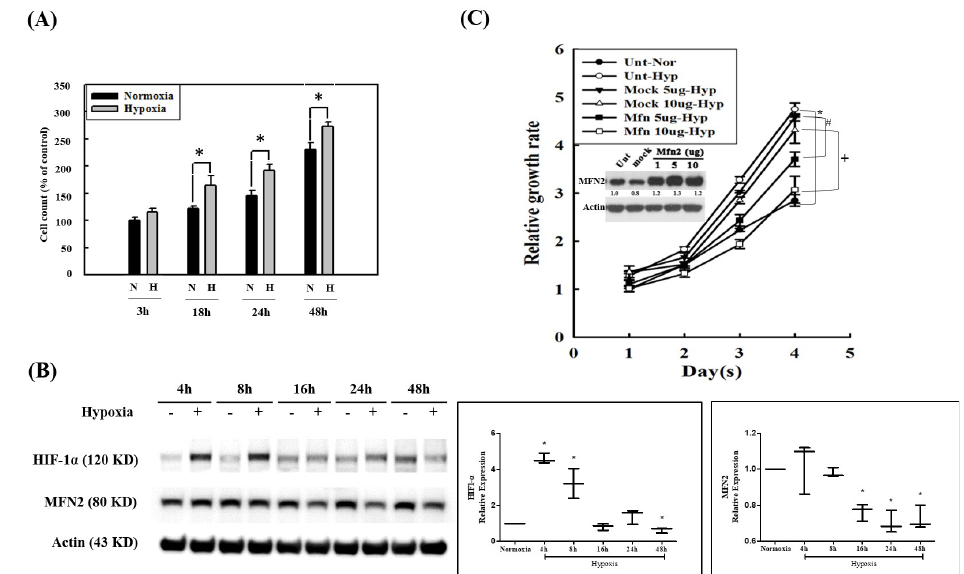
Figure 1. The role of MFN2 in hypoxia-induced proliferation. ( A ) HPASMCs were exposed to hypoxic (1% oxygen) or normoxic conditions for 3, 18, 24, and 48 h, respectively. Cell viability was detected using a CCK8 assay. * p < 0.05 hypoxic group versus normoxic group. The statistical difference was analyzed by an unpaired t -test and the data represented by means ± standard error of three independent experiments. ( B ) HPASMCs were exposed to the hypoxic (+) or normoxic ( − ) conditions for different times. Expression of HIF-1 α and MFN2 was detected by Western blotting. Expression of actin was used as a loading control. The boxplots on the right show HIF-1 α /actin and MFN2/actin ratios under hypoxia conditions divided by HIF-1 α /actin and MFN2/actin ratios under normoxic conditions, respectively. The statistical analysis was performed with the normoxic conditions at each time point as 1. * p < 0.05 hypoxic group versus normoxic group. The statistical difference was analyzed by an unpaired t -test and the data represented by means ± standard error of three independent experiments. ( C ) HPASMCs were transiently transfected with the vector alone or the MFN2 plasmid. The expression of MFN2 was determined by Western blotting. Data indicated that the transfection condition is appropriate to successfully promote the expression of MFN2 in PASMCs. One, five, and ten micrograms of MFN2/pCMV3 transfection can effectively increase the expression of MFN2 in HPSMCs. Cell viability of five and ten micrograms of MFN2/pCMV3 transfected groups was detected at 1 to 4 days using a CCK8 assay. Both five and ten micrograms of the MFN2/pCMV- transfected groups inhibited the hypoxia-induced proliferation of HPASMCs. The statistical difference was analyzed by an unpaired t -test and the data are represented by means ± standard error of three independent experiments. * p < 0.05 hypoxic group ( ) versus (cid:35)